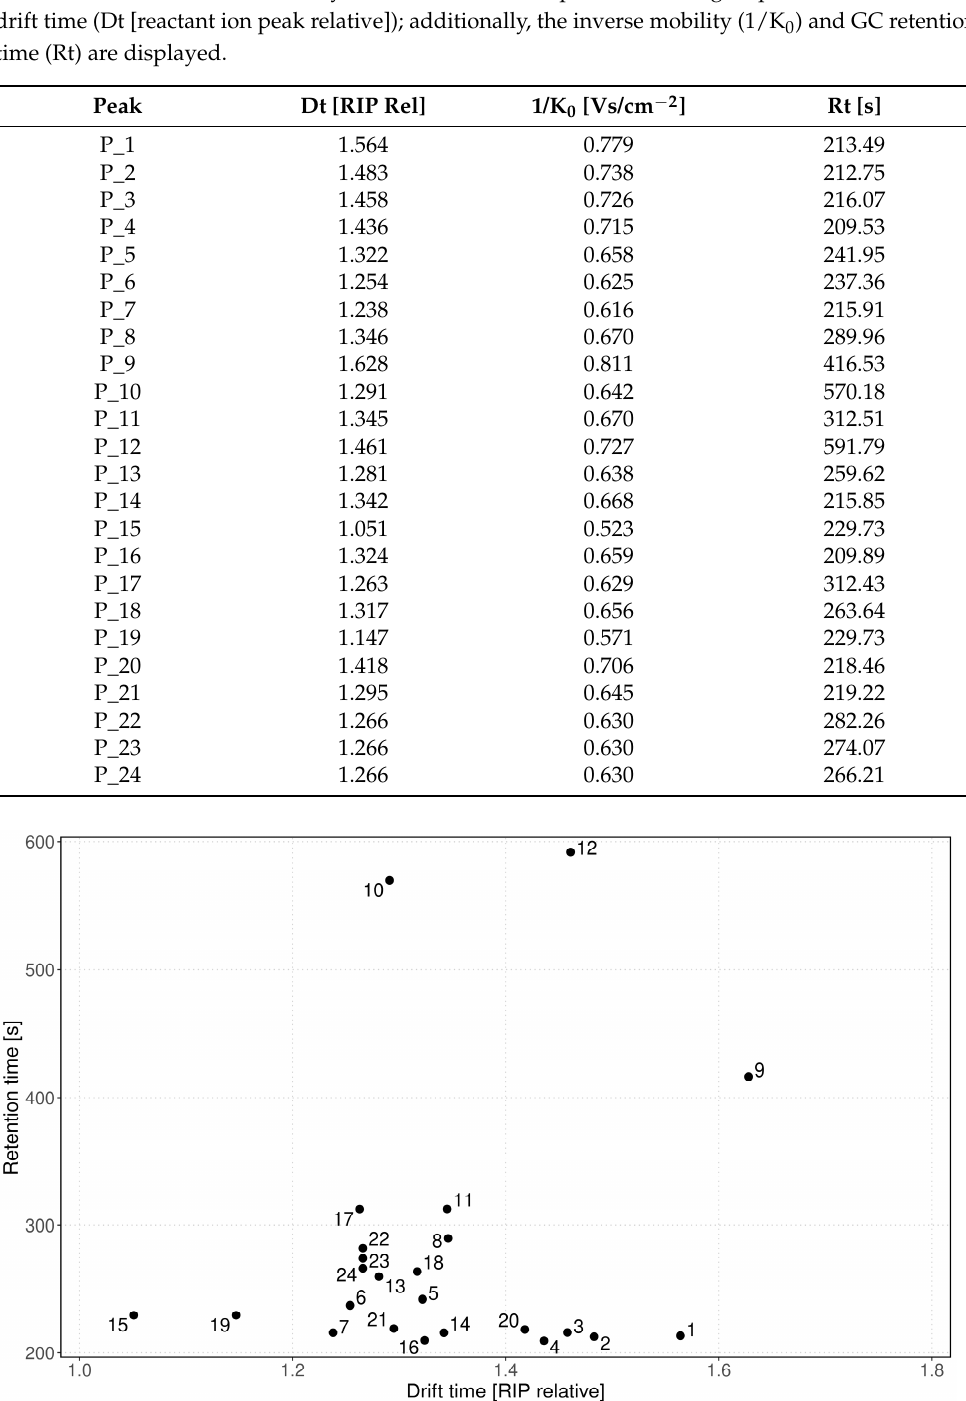
Figure 3. Development of SI (mean with corresponding 95%-CI) for control (green, n = 6) and EC group (red, n = 6) of two exemplary peaks (P_1; P_15) in aerobic (left) and anaerobic (right) media against time. An SI increase can be observed after 6–8 h.